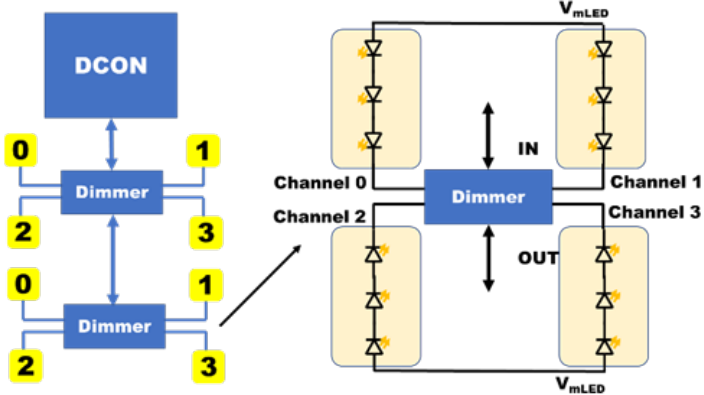
Figure 2. The concept of single X-wire AM control method and its building blocks.